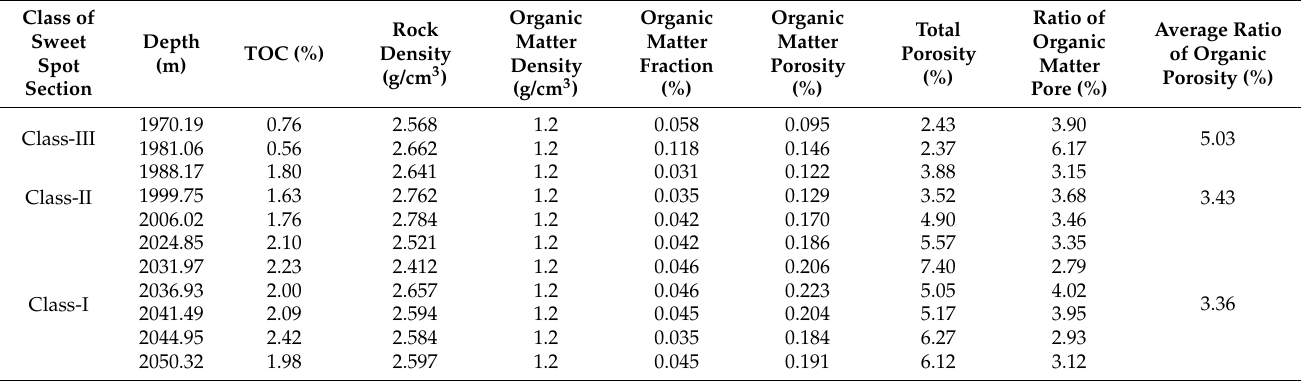
Table 2. Parameters of organic matter pores in shale samples from K 2 qn 1 Member of Da’an area, southern Songliao